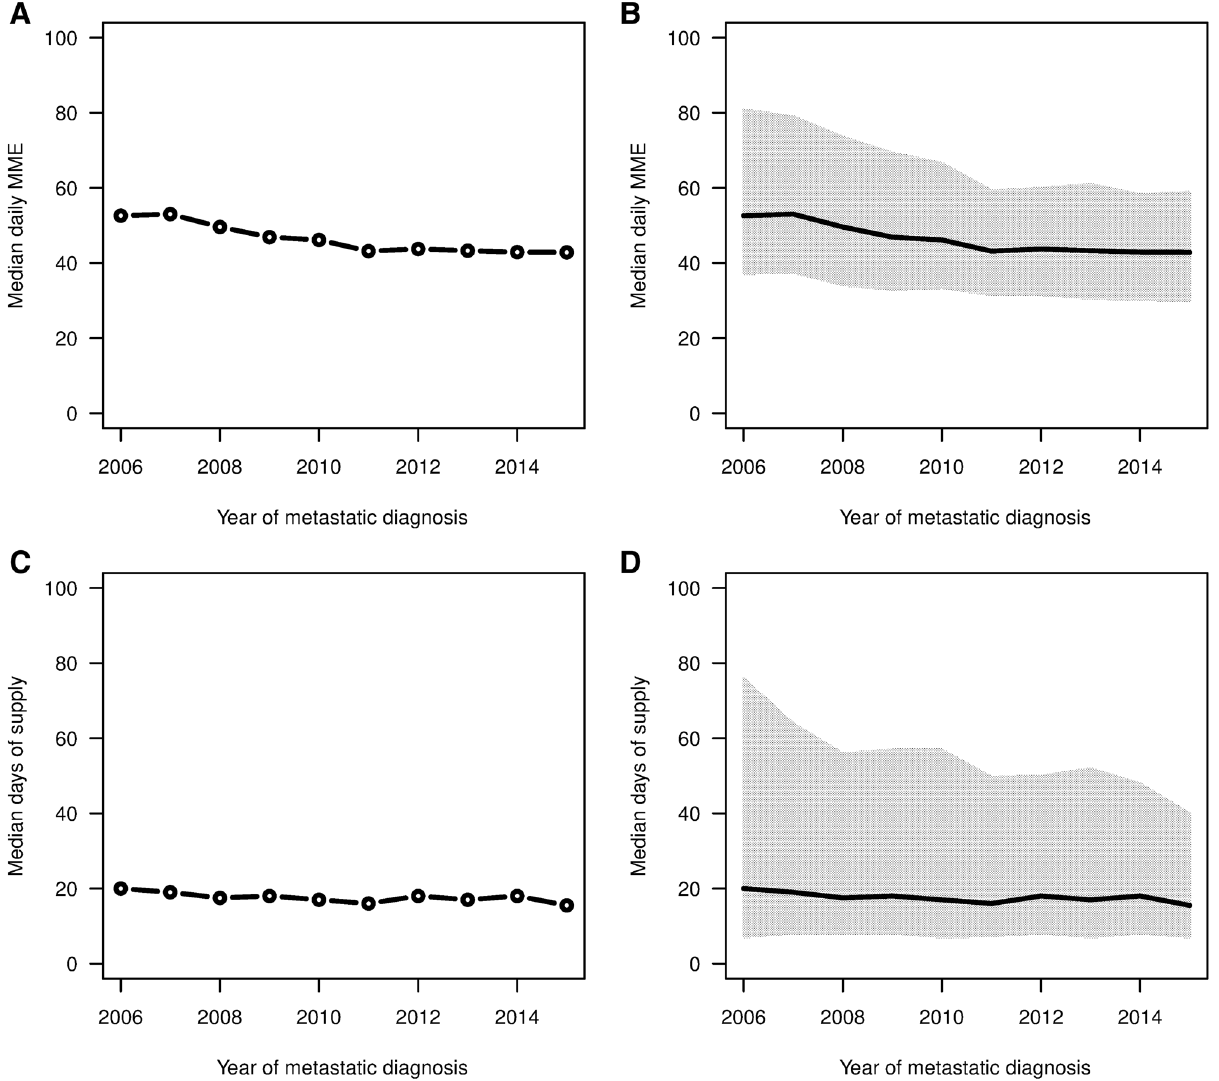
Figure 2. Median daily MMEs and median days of supply within 12 months of the metastatic diagnosis date (left) with IQRs (right) by calendar year for patients who had at least one opioid prescription after the metastatic diagnosis date. Using R software (https ://www.R-proje